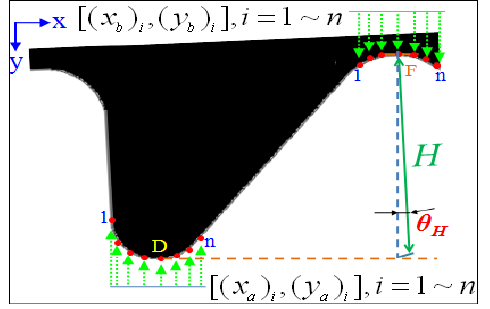
Figure 9. “All tooth stature